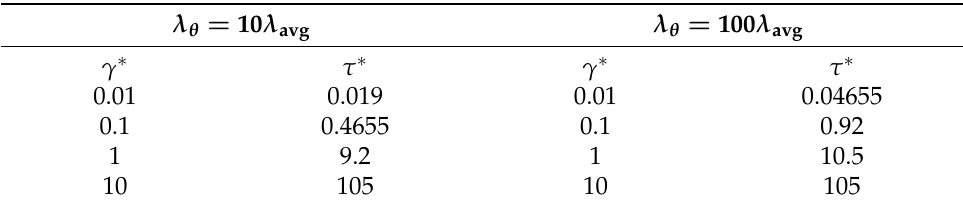
Table 4. Damage parameters used to match the rheology of the rate-controlled approach ( γ ∗ ) and the stress-controlled approach ( τ ∗ ) at the characteristic shear rate ˙ γ c for two different recovery time scales.